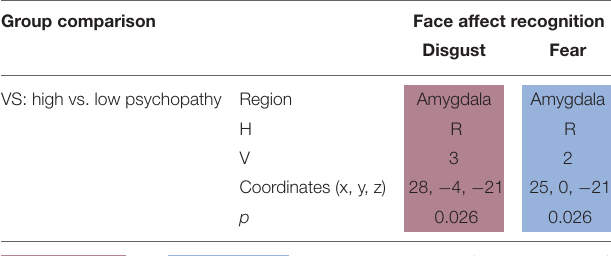
TABLE 4 | Activation patterns in face affect